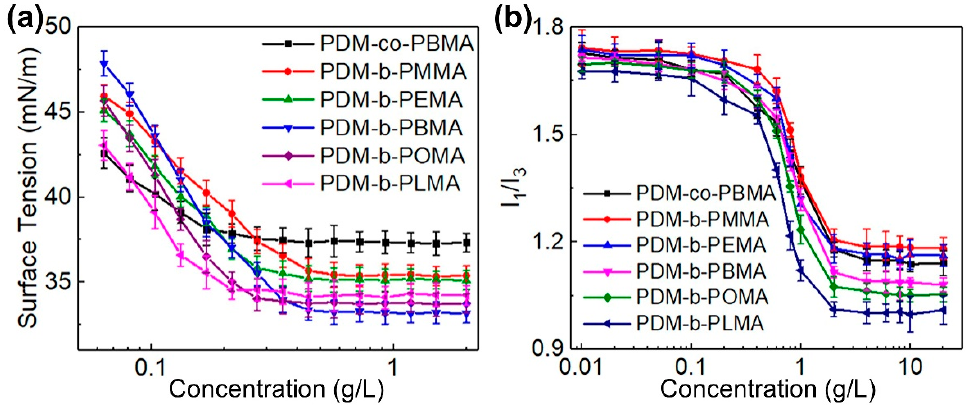
Figure 6. E ff ect of HSC length on the surface tension of PDM- b -PRMA ( a ). Relationship between PDM- b -PRMA concentration and I 1 /1 3 ( b ).